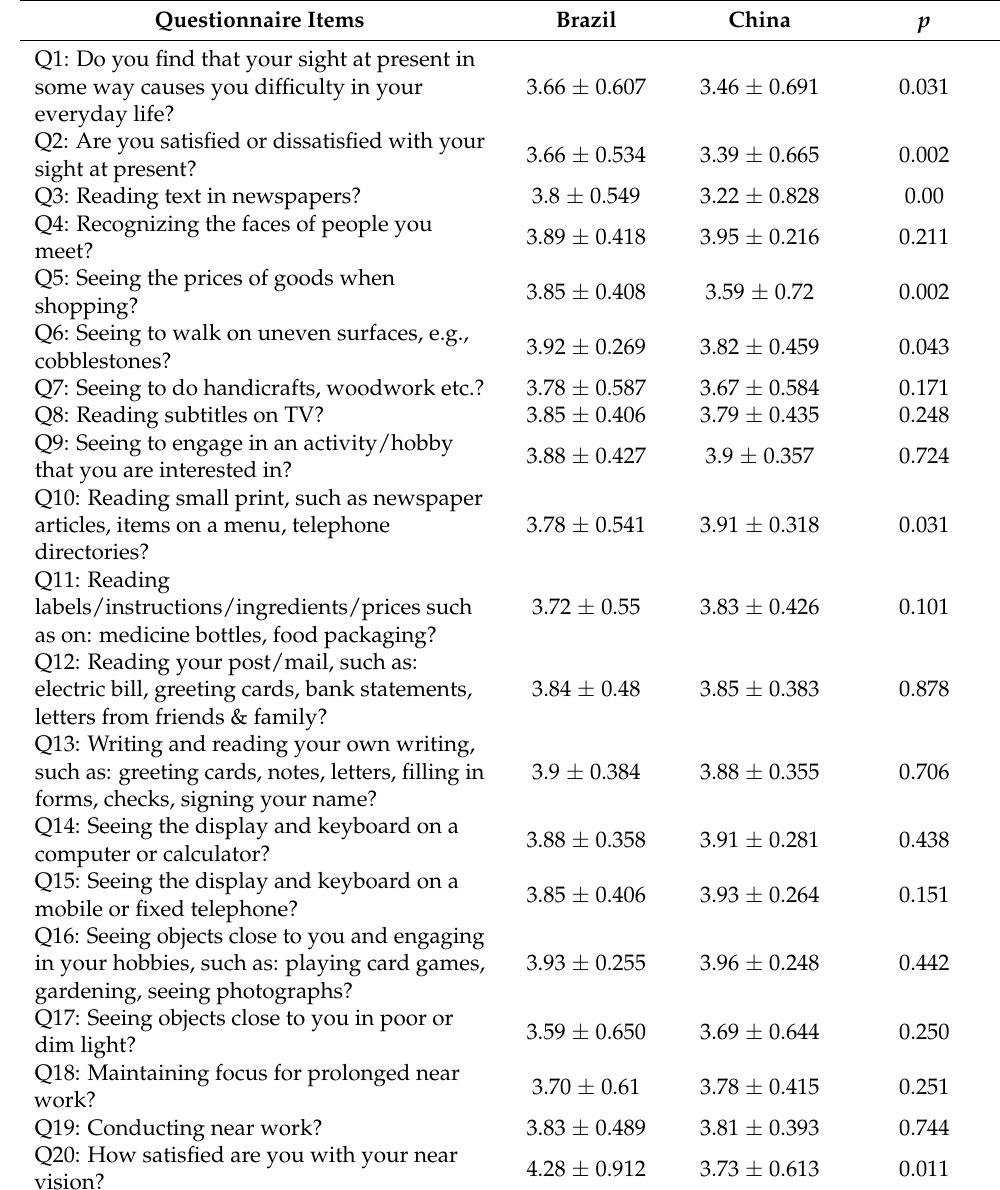
Table 3. Quality-of-life questionnaire scores for Brazil and China. Questionnaire Items Brazil